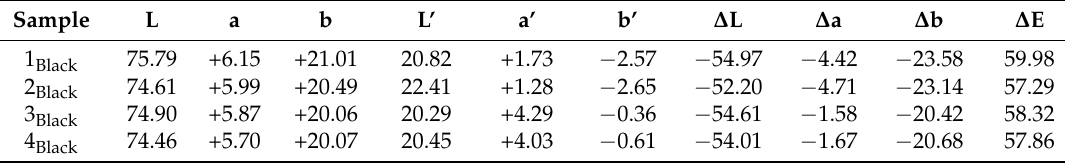
Table 3. L 4 (2 3 ) orthogonal test of chromatic aberration with reactive black.